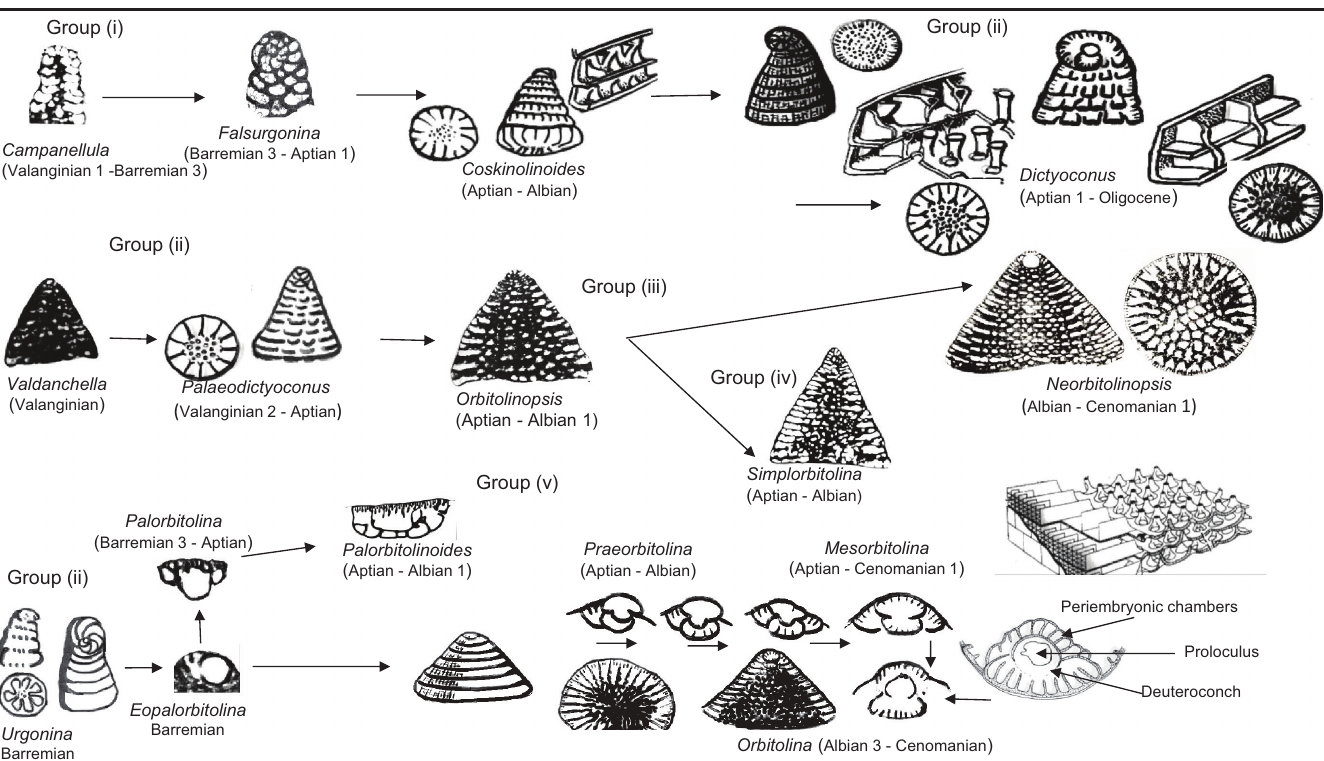
Gradual morphological changes from primitive orbitolinids to the advanced Orbitolina in Tethys.